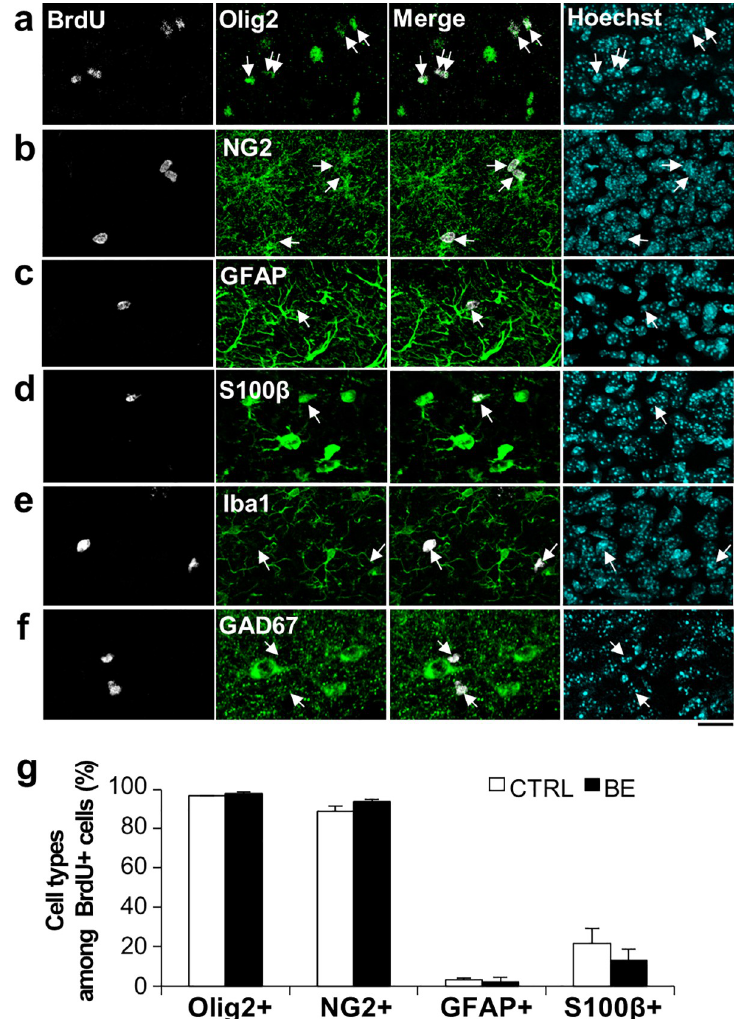
Fig 2. Cell type determination of BrdU+ cells at P25. ( a-f ) Confocal images of Olig2+ ( a ), NG2+ ( b ), GFAP+ ( c ), S100 β + ( d ), Iba1+ ( e ), or GAD67+ ( f ) cells (green) along with BrdU+ cells (gray, arrows) in the bottom lamina (Bin 8) of V1 at P25. Scale bar, 20 μ m. ( g) Percentages of Olig2+, NG2+, GFAP+, and S100 β + cells among BrdU-labeled cells. N = 6 for Olig2+; N = 5 for NG2+; N = 3 for GFAP+; N = 5 for S100 β + images. Unpaired Student’s t-test, p > 0.05. BrdU+ cells were co-stained against astrocyte markers GFAP or S100 β (Fig 2C, 2D and 2G). While GFAP-expressing BrdU+ cells were few, about 20% of them expressed S100 β . This rela- tively high proportion of S100 β expression is not surprising since it could be expressed in OPCs [40] and maturing oligodendrocytes. No BrdU+ cells expressed Iba1 (Fig 2E), suggesting that the proliferated cells do not likely include microglia. BrdU+ cells did not express GAD67, a GABAergic neuron marker (Fig 2F). Taken together, these data suggest that the proliferative cells elevated at P25 were essentially all oligodendrocyte lineage cells and mostly NG2 glia. Additionally, we also examined if BE affected cell densities of these cell types (Fig 2G). We found no evidence of BE-induced changes in them. Since BE altered Ki67 expression without altering BrdU+ cell densities, these data suggest that BE affects cell cycle state or differentiation state without altering cell types.